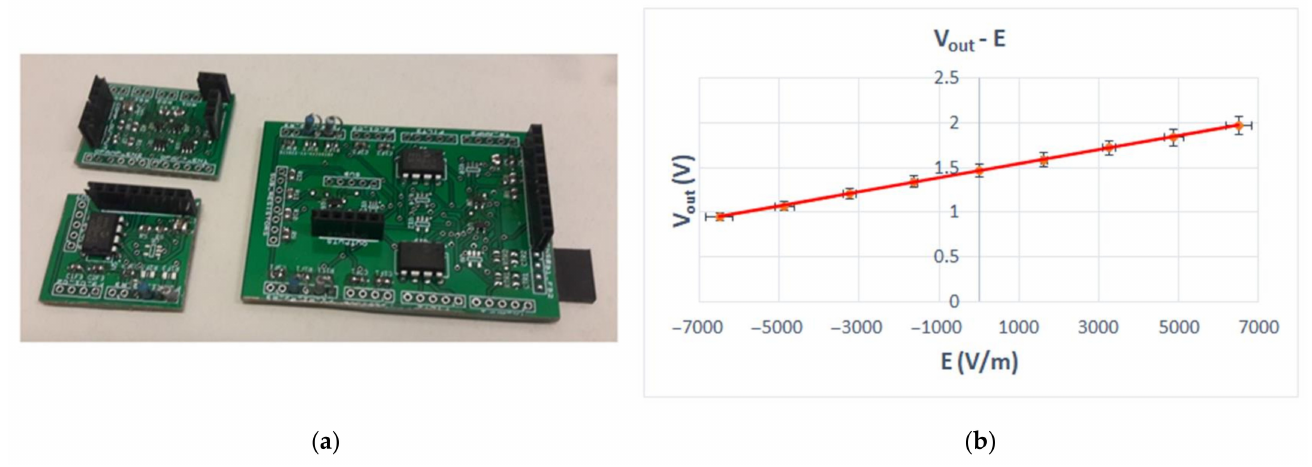
Figure 7. ( a ) Discrete implementation of the proposed sensor interface; ( b ) output voltage vs. electric field (linear equation: V out = 8 × 10 − 5 E + 1.4622 V, R 2 =